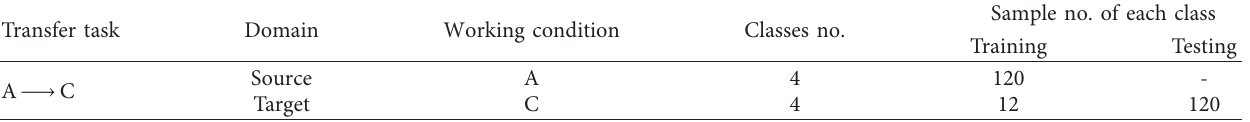
Table 2: Setting details of transfer task A ⟶ C.